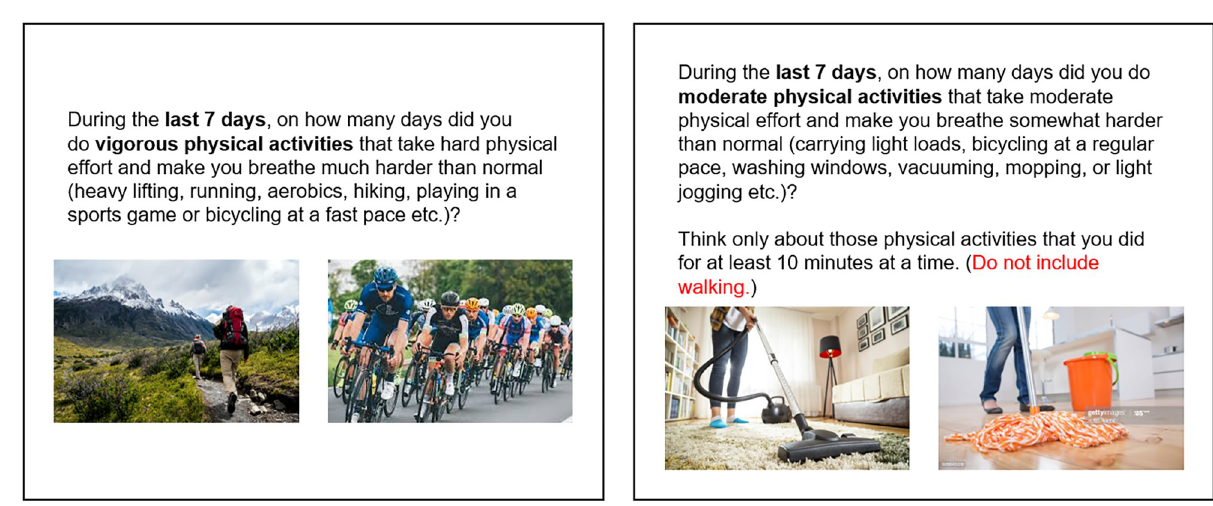
Fig 2. Examples of the modified IPAQ questionnaires used in our